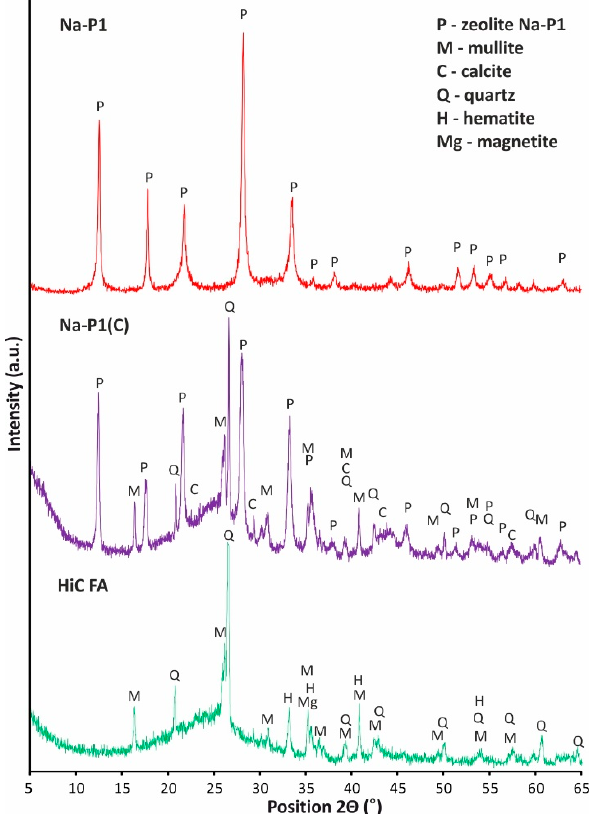
Diffractograms of the phase composition of high-carbon fly ash, Na-P1(C) composite and pure Na-P1 zeolite are shown in Figure 6.